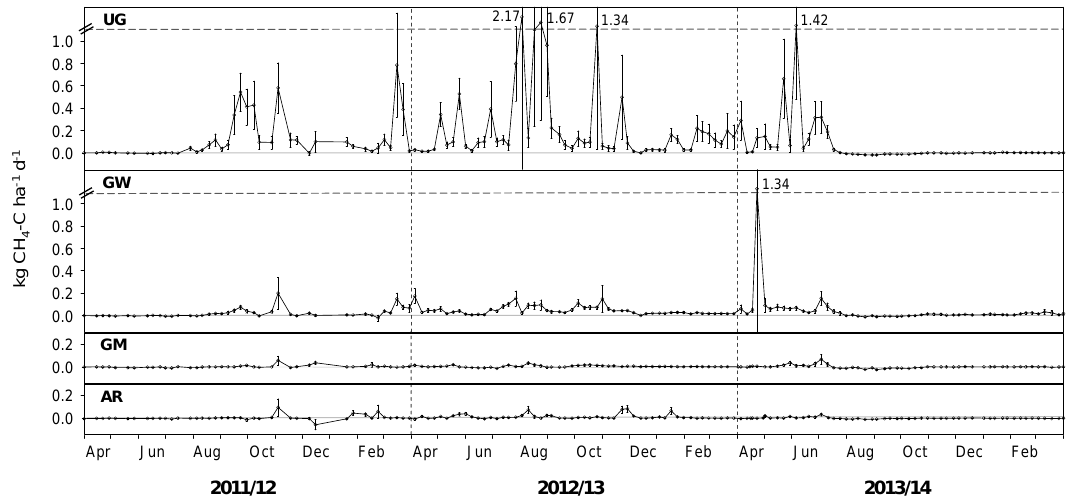
Figure 3. CH 4 exchange at the four study sites during the study period (April 2011–March 2014). Values are displayed as mean ± standard error ( n = 8). Note the broken y axis for sites UG and